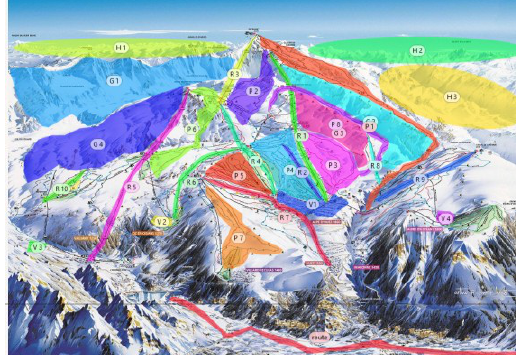
Figure 3 . Area Of Interest polygons depicted on the Alpes d’Huez ski map for task1.